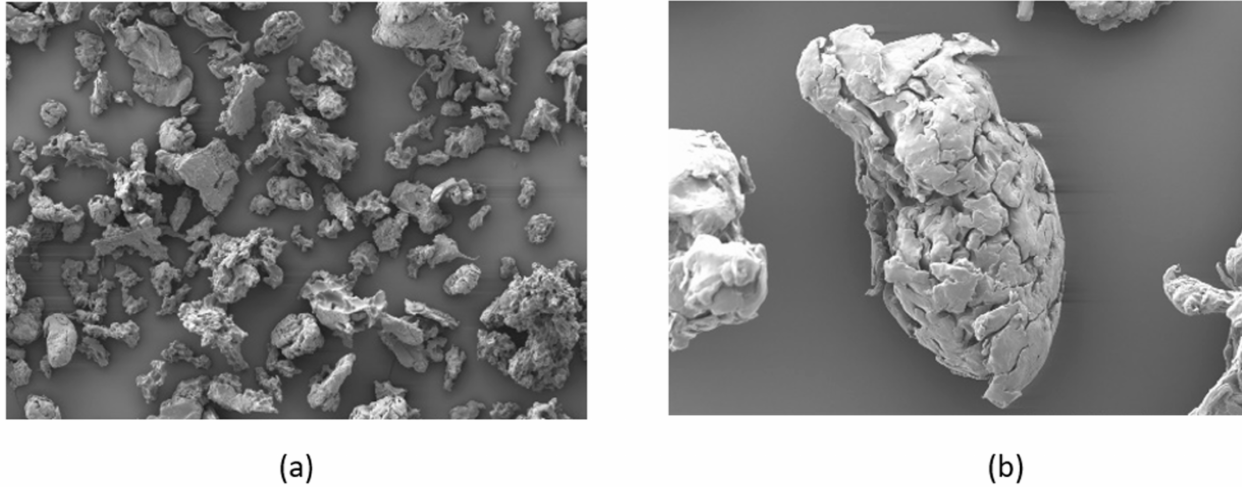
Figure 1. Scanning electron microscope (SEM) images of PPSF powder particles, ( a ): 100 × zoom, ( b ): 500 ×